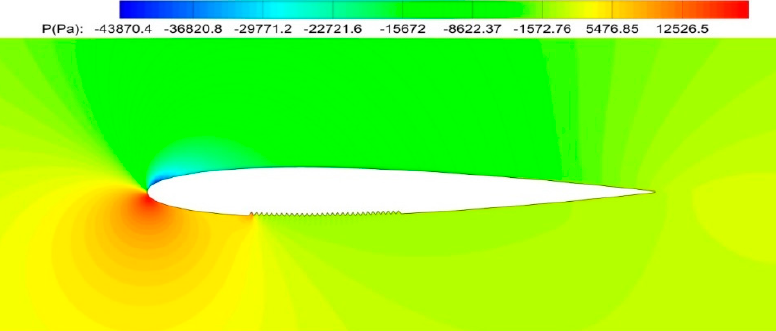
Figure 17. 4° angle of attack, pressure distribution of grooves on the pressure side. Figure 16. 4° angle of attack, pressure distribution of standard NACA0012 airfoil. Figure 17. 4 angle of attack, pressure distribution of grooves on the pressure